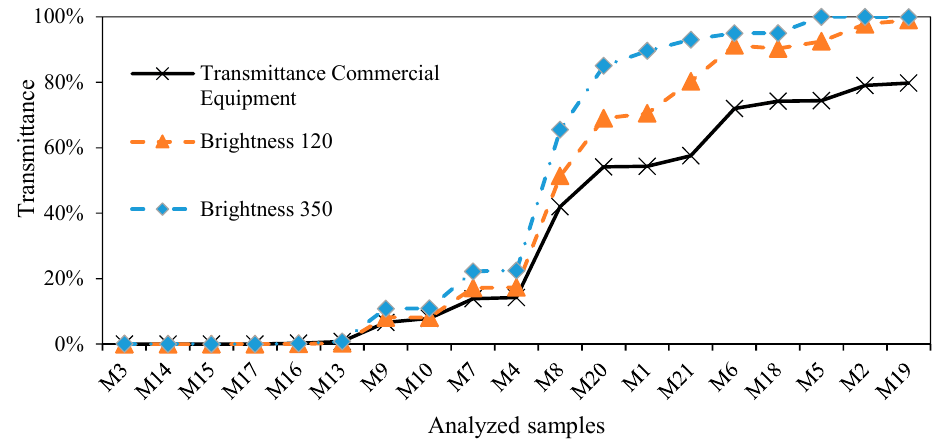
Figure 3. Emission spectrum of 385 nm LED (VAOL-5EUV8T4) [30].